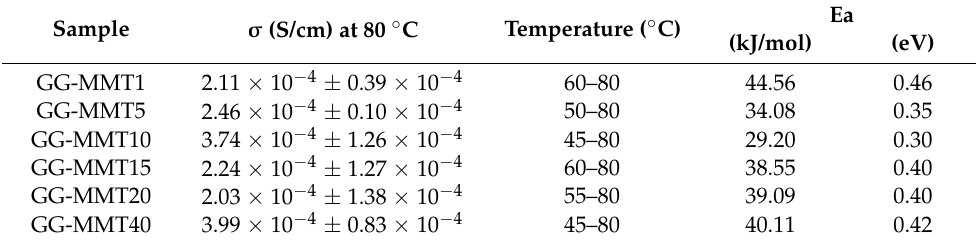
Table 4. Ionic conductivity and activation energy at 80 ◦ C of GGLA